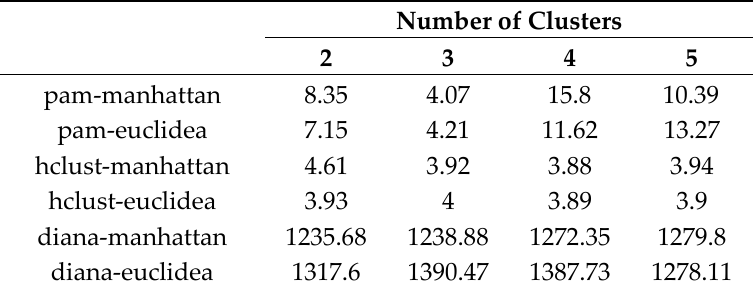
Table 3. Elapsed CPU times in seconds for each clustering